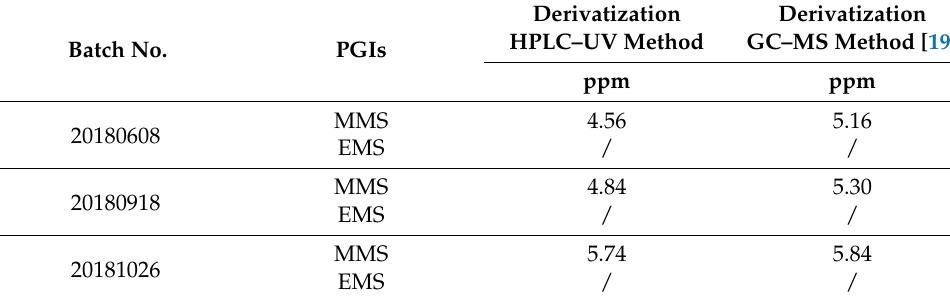
Table 3. Determination results by the two analytical